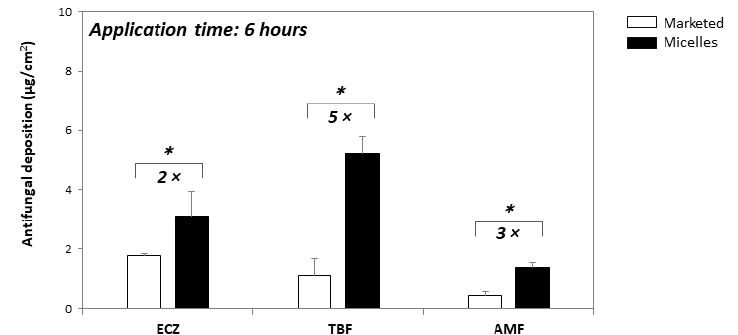
Figure 4. Comparison of the amount of each antifungal deposited from marketed formulations and from the “tri-therapy” following formulation application under infinite dose for 6 h (mean ± SD, n ≥ 5). * p <